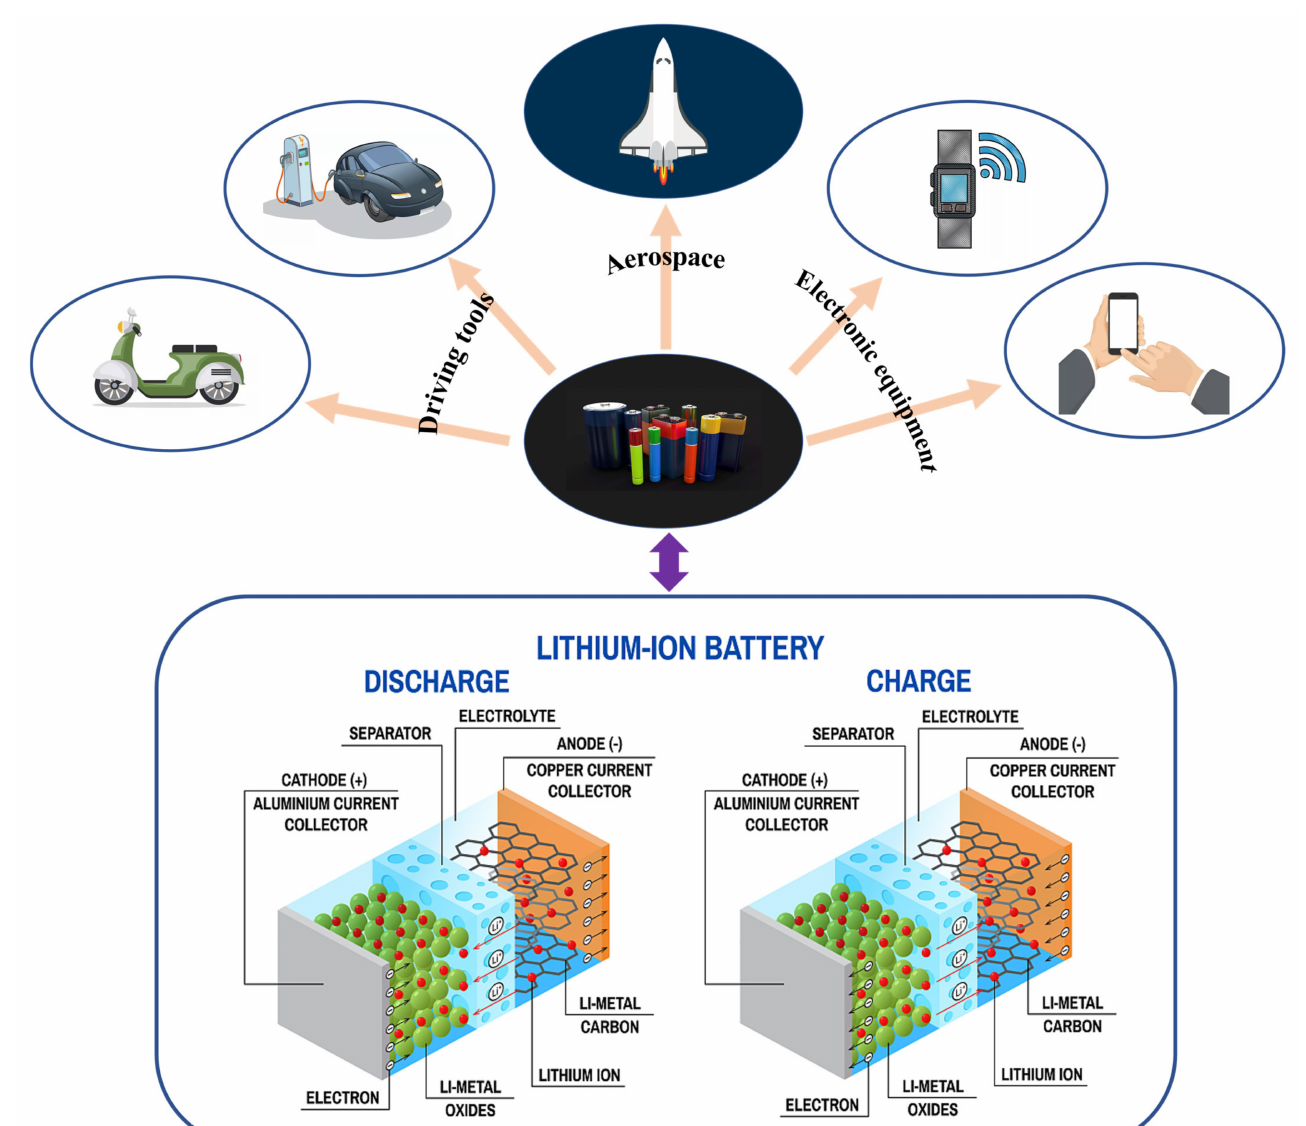
Figure 1. Application scenario and working principle of